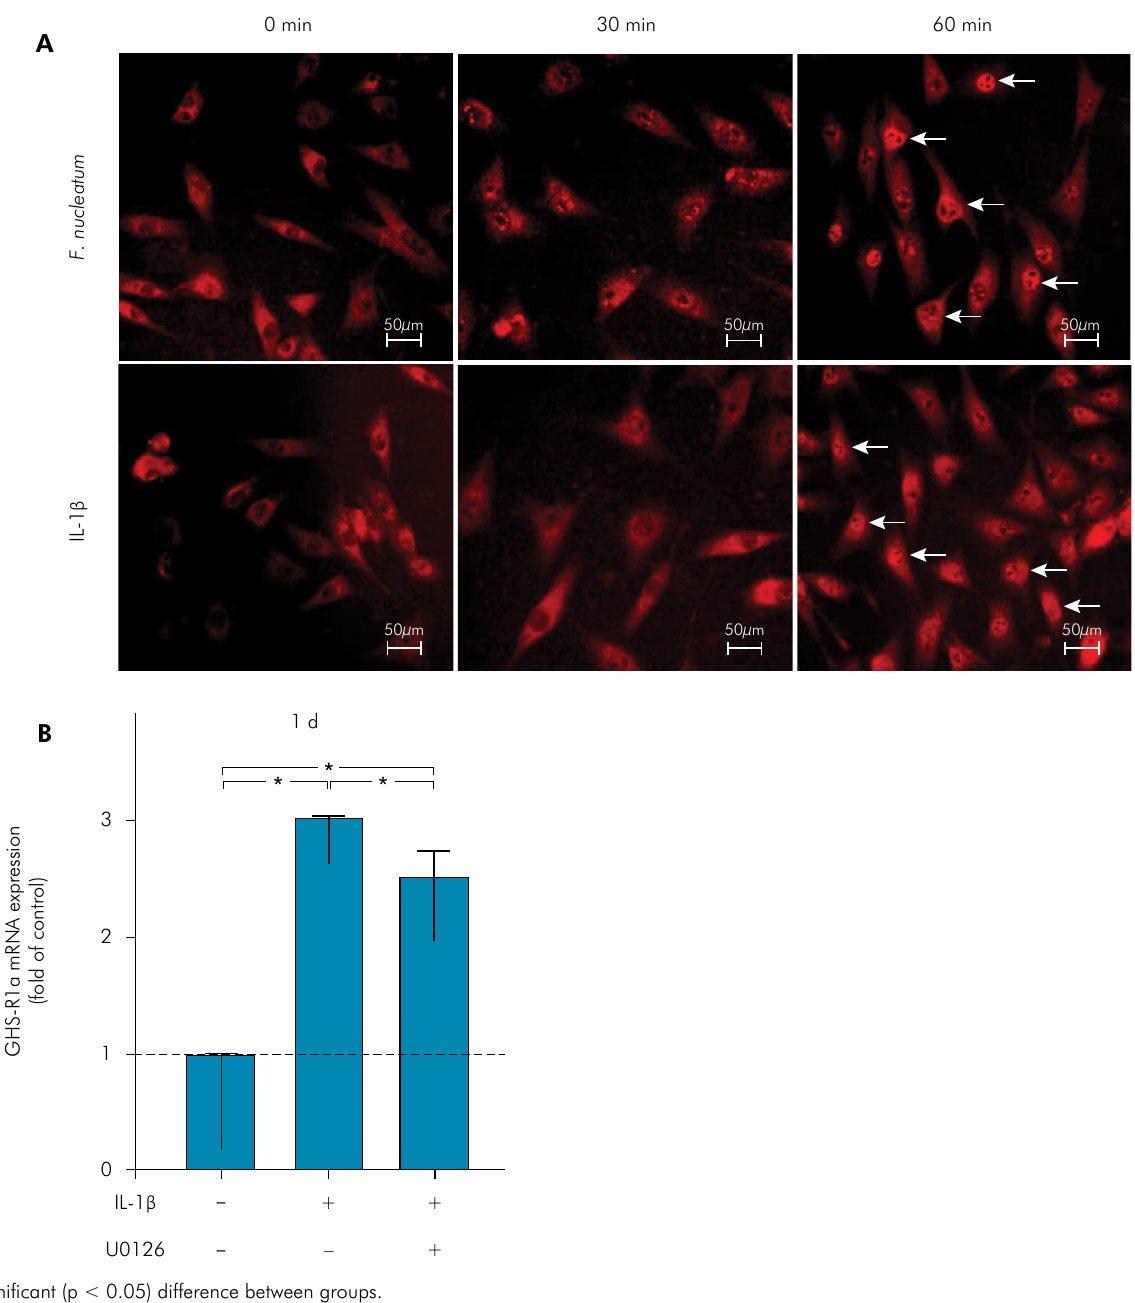
Figure 2. (A) NF- κ B (p65) nuclear translocation in response to F. nucleatum ( Fn ; OD: 0.1) or IL-1 β (1 ng/ml) over time. Representative images from one out of three experiments are shown. Indicator arrows show some cells presenting nuclear translocation of p65 at 60 min. (B) GHS-R1a expression in response to IL1 β (1 ng/ml) in the presence and absence of a MEK1/2 inhibitor (U0126; 10 µM) at 1 d. Mean ± SEM ( n